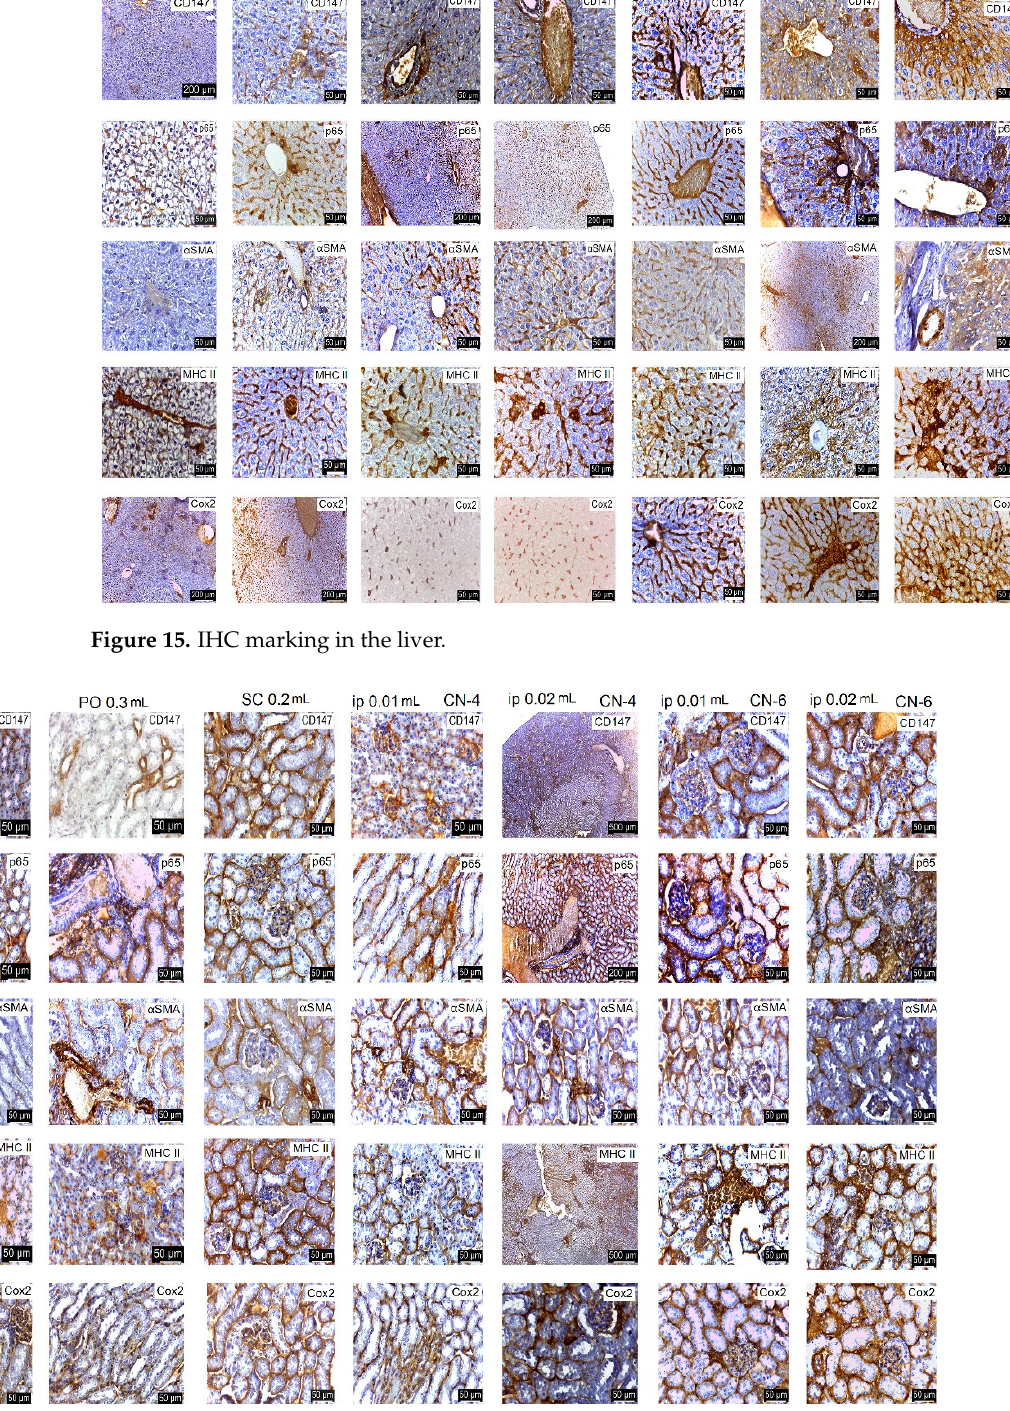
Figure 16. IHC labeling in kidneys.